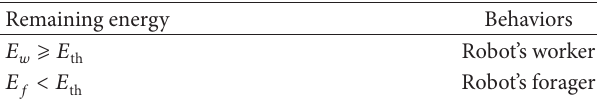
Robot’s worker Robot’s